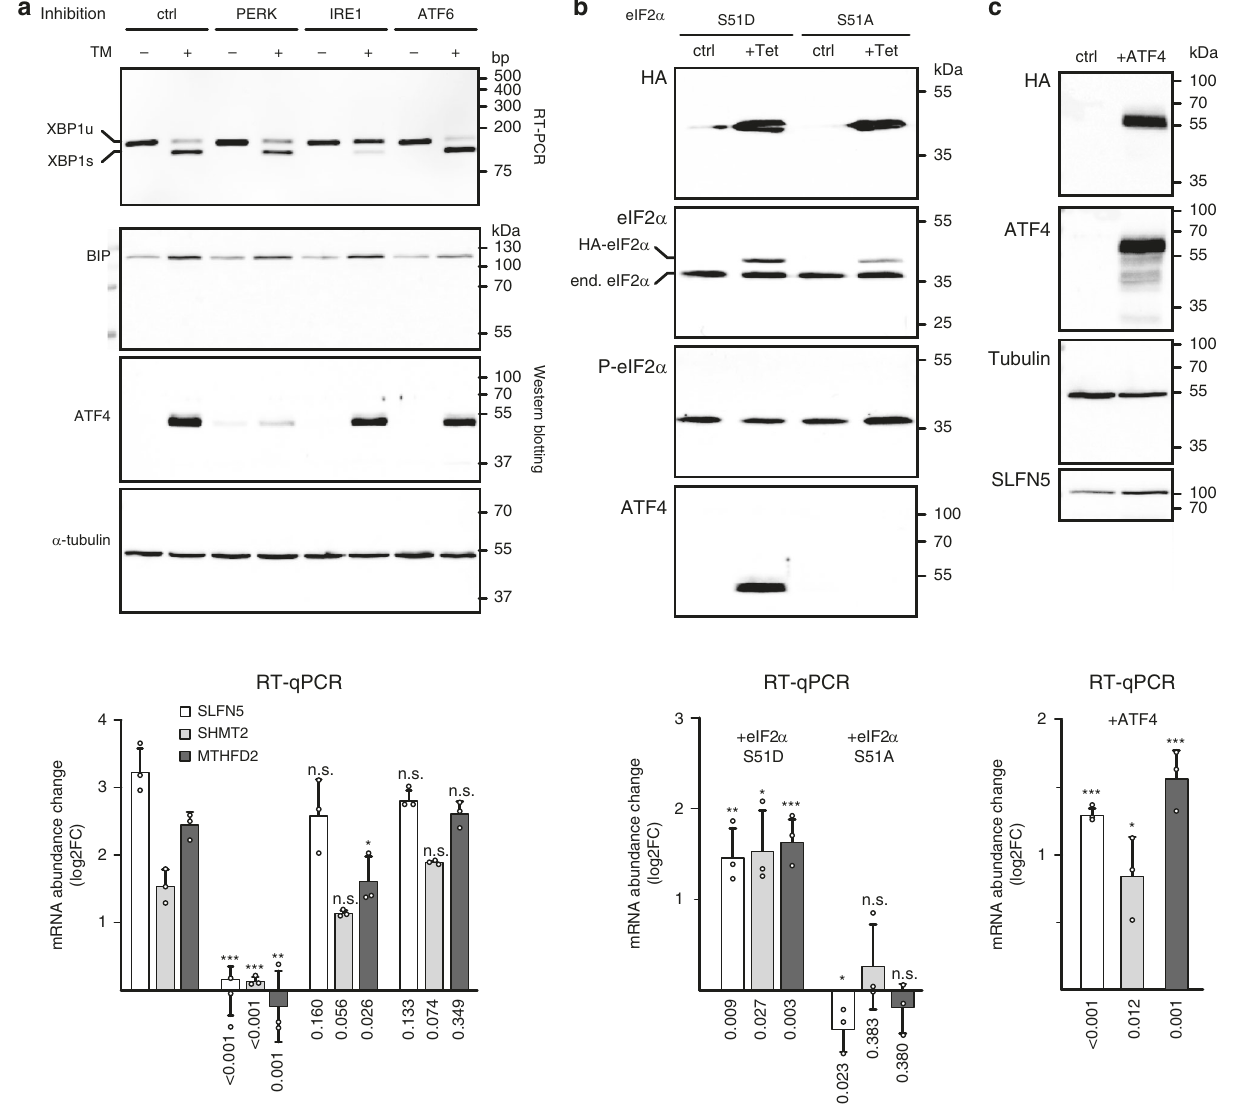
Fig. 4 SLFN5, SHMT2, and MTHFD2 are induced by the UPR via the PERK – EIF2S1 – ATF4 pathway. a Gene expression analysis of SLFN5, SHMT2, and MTHFD2 mRNAs after activation of the UPR in LN-308 cells. In parallel to stimulation with TM (lanes denoted + ), either PERK, IRE1, or ATF6 were inhibited with small molecules (as indicated at the top). DMSO treatment served as a control. After 6 h, changes to gene expression were monitored. Top panel: RT-PCR analysis of IRE1-mediated cytoplasmic processing of XBP1 mRNA. Middle panels: Western blotting analyses of BiP (HSPA5), ATF4 and α - tubulin protein levels. Bottom: analysis of SLFN5 (white bars), SHMT2 (light gray bars) and MTHFD2 (dark gray bars) mRNA abundance by RT-qPCR. Plotted are mRNA abundance changes (log2 FC) relative to the control treatment and normalized to GAPDH mRNA levels. b Expression analysis of SLFN5, SHMT2, and MTHFD2 mRNA abundance in HEK293 cells after expression of a phosphomimetic eIF2a protein (lanes S51D), or a non-phosphorylatable variant (lanes S51A). After 24 h of induction (lanes + Tet), expression of the mutant proteins is monitored relative to control samples (ctrl). Top panels: Western blotting analyses with antibodies that recognize either the HA-tag of the stably transfected eIF2a protein-encoding constructs (top panel), total eIF2 α (second panel), S51 phosphorylated eIF2 α (third panel), or ATF4. Bottom: analyses of mRNA abundance as described for a . c Expression analysis of SLFN5, SHMT2, and MTHFD2 mRNA abundance in LN-308 cells after transient expression of ATF4. Western blotting analyses of protein expression using antibodies speci fi c for the HA-tag of the transfected construct, ATF4, tubulin, or SLFN5. Bottom: RT-qPCR analysis as described for a . Experiments were performed in at least three biologically independent experiments, representative blots/gels are shown (uncropped images are provided in the supplementary information). Molecular weight markers (in kDa) or DNA size markers are indicated on the right of each panel. qPCR data are represented as mean ± SD of three biologically independent experiments measured in technical triplicates (dots represent average values of three technical replicates). P -values are provided below each bar, n.s. not signi fi cant P > 0.05; * P < 0.05, ** P < 0.05, *** P < 0.01 as determined by a Student ’ s t -test (two-sided, true variance equality, con fi dence level 0.95, no adjustment for multiple